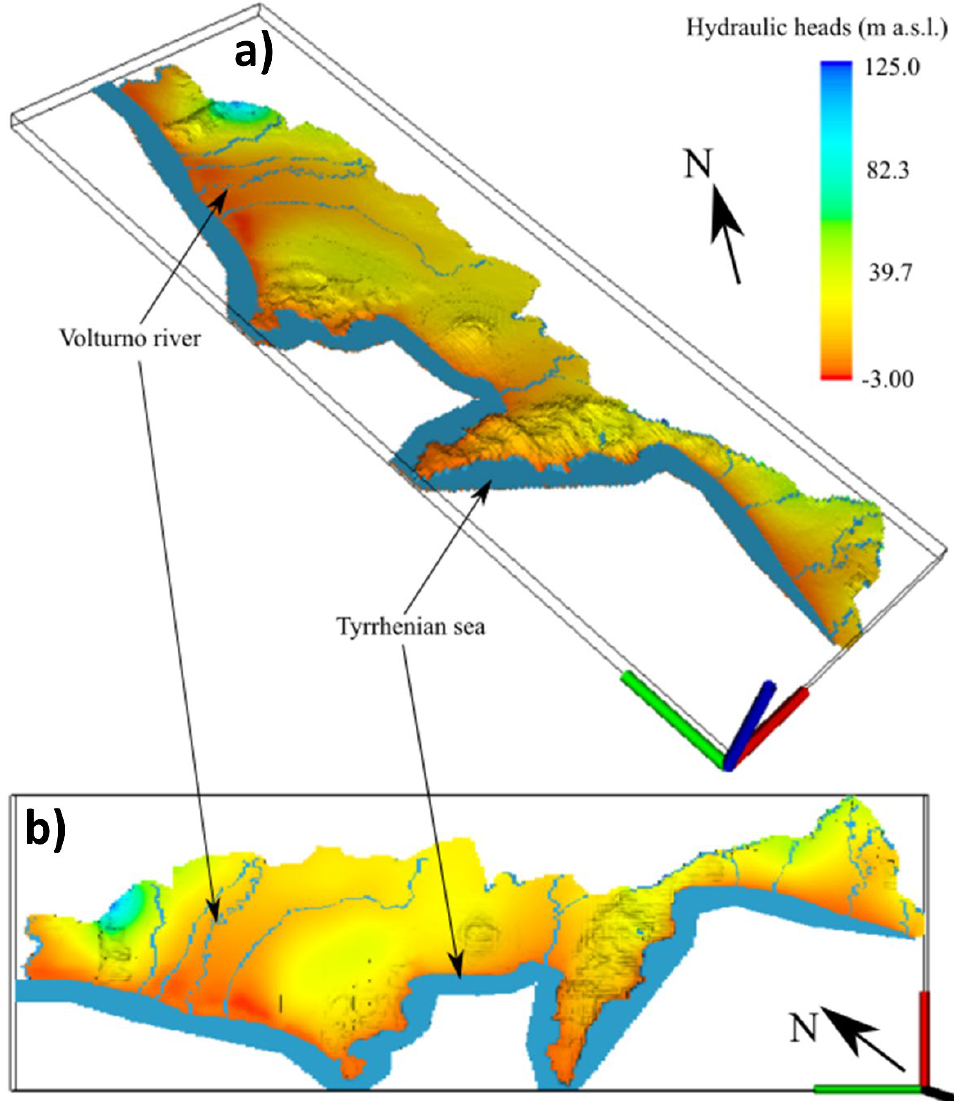
Figure 4. Three-dimensional sketch ( a panel ) and plan view ( b panel ) of the model calculated hydraulic heads map at the end of the simulation time.